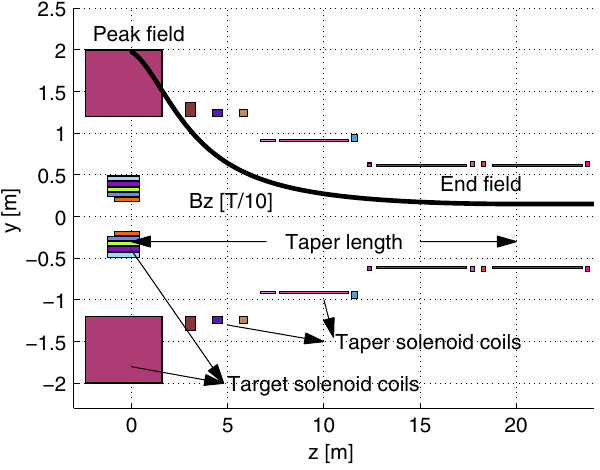
FIG. 2. Muon collider baseline target solenoid coils [4]. The on-axis solenoid field peaks at 20 T then tapers down to 1.5 T.